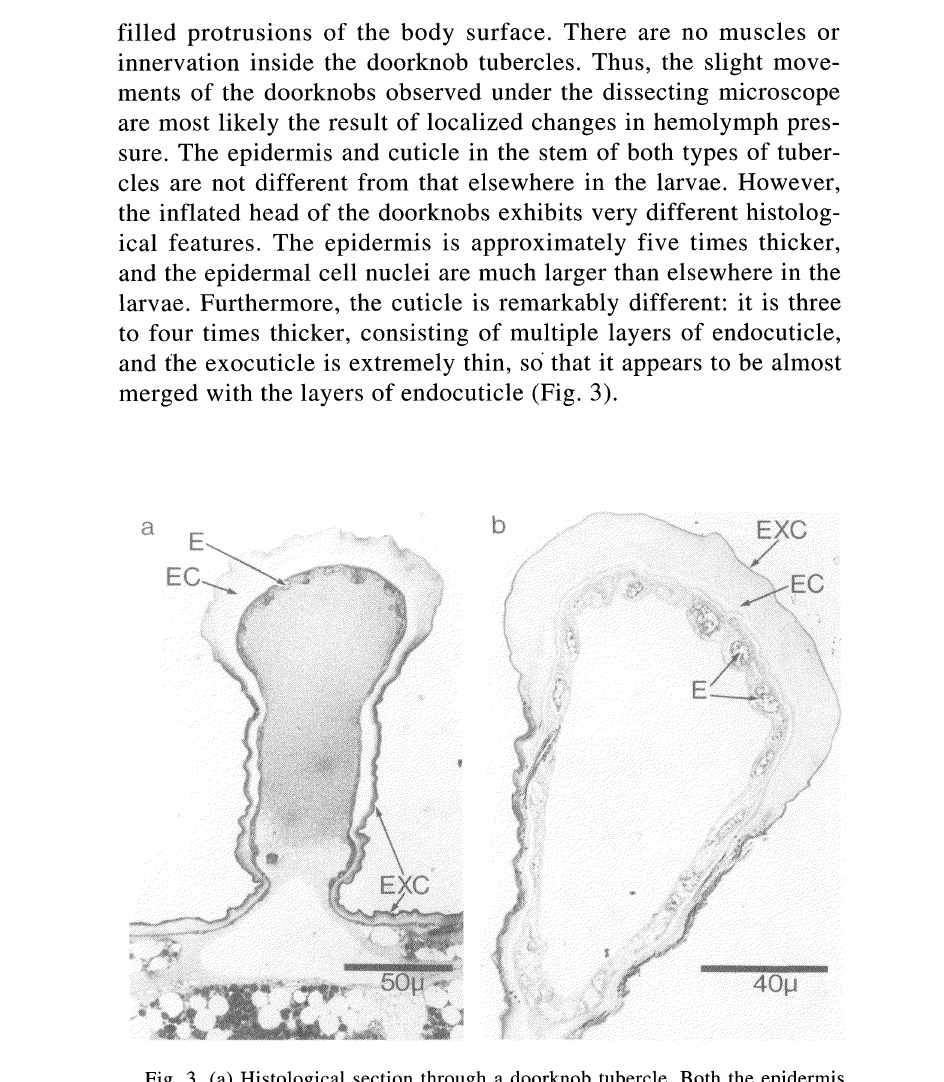
Fig. 3. (a) Histological section through a doorknob tubercle. Both the epidermis (E) and the endocuticle (EC) are thickened, while the exocuticle (EXC) thins out in the spherical tip of the doorknob structure (b) Section through the tip of the doorknob tubercle, showing the glandular epithelium of the epidermis (E), the multi-layered endocuticle (EC) and the thinned-out exocuticle